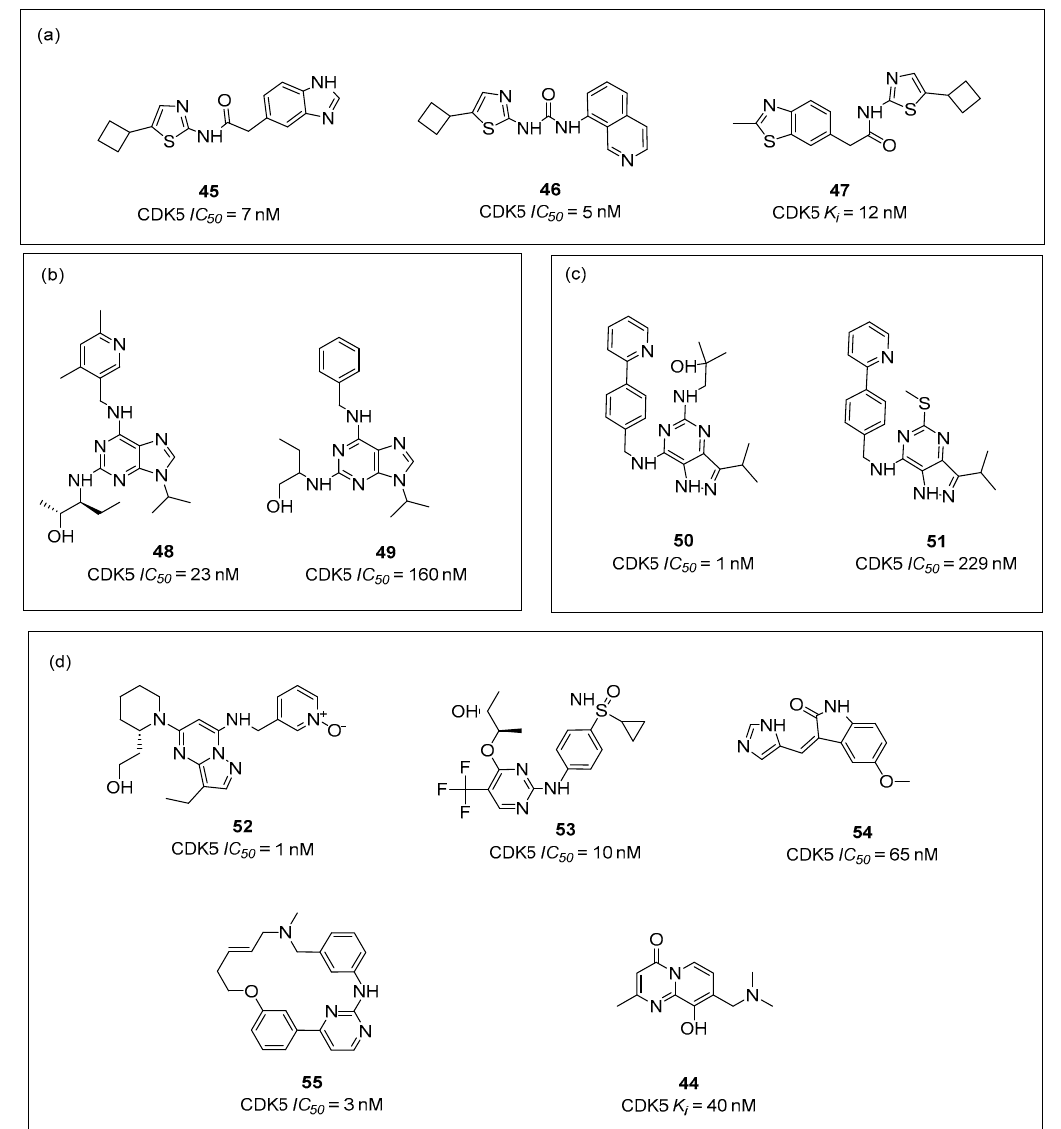
Figure 13. Examples of inhibitors of CDK5 with their affinities ( IC 50 or K i ) within group ( a – d ) 45